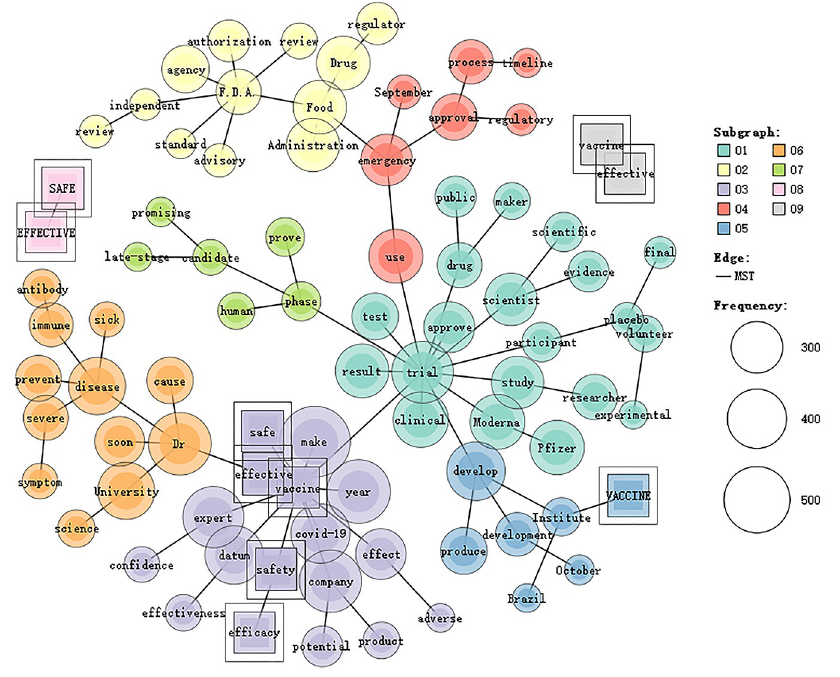
Fig 1. Co-occurrence network of the five tokens in